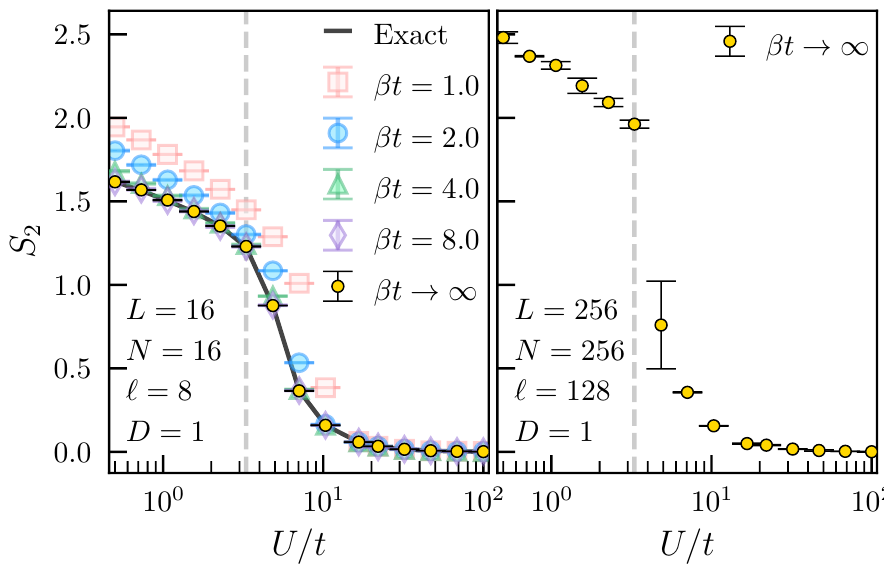
Figure 10: (left) Full Rényi Entanglement Entropy S for a 1D Bose-Hubbard lattice 2 with L = 16 sites at unit-filling under an equal spatial bipartition of size ℓ = 8 at various interaction strengths U . The entropies were measured from simulations at four different values of β t . As expected, the exact ground state value (solid black line) is approached as β t increases. The vertical dashed line at U = 3.3 is the exact value of the 1D Superfluid-Mott Insulator phase transition. The solid circles are large β t extrapolations of S obtained from a three-parameter exponential fit of S results 2 2 at β t = 4,6,8,10,12. (right) Full Rényi Entanglement Entropy S for a 1D Bose- 2 Hubbard lattice with L = 256 sites at unit-filling under an equal spatial bipartition of size ℓ = 128 at various interaction strengths U / t